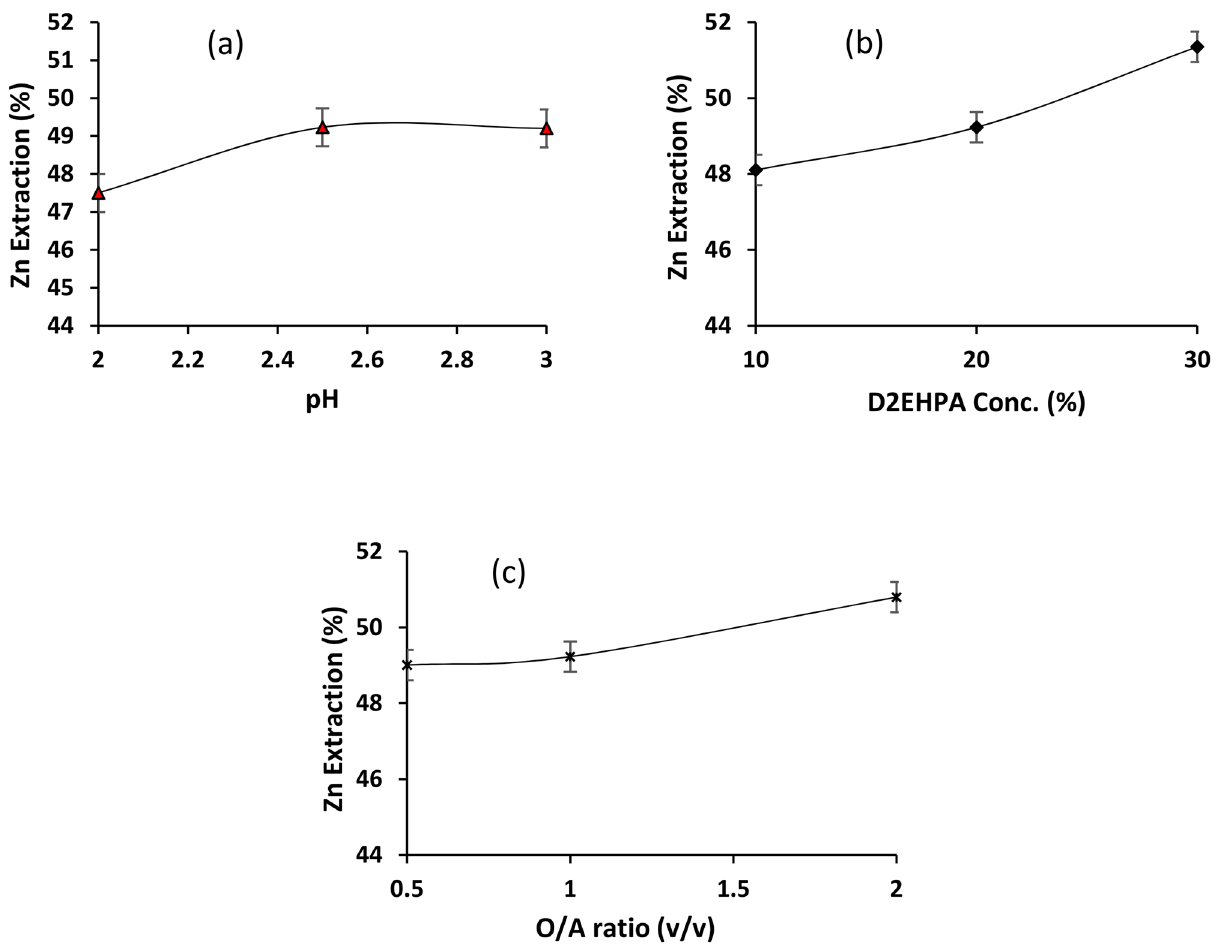
Figure 6. Effect of ( a ) pH, ( b ) D2EHPA concentration, and ( c ) organic phase to aqoueous phse ratio on the solvent extraction of Zn from the neutralized